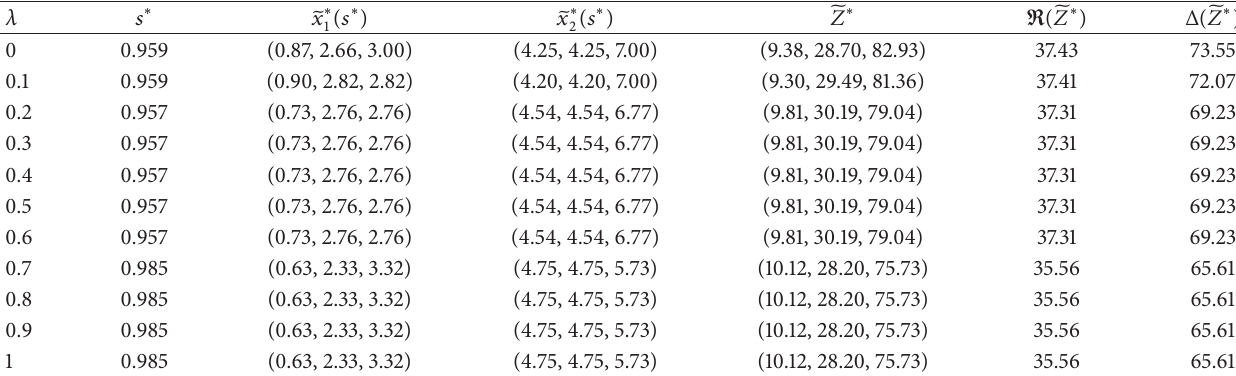
Table 3: The 𝑠 ∗ -fuzzy-optimal solutions with different value of 𝜆